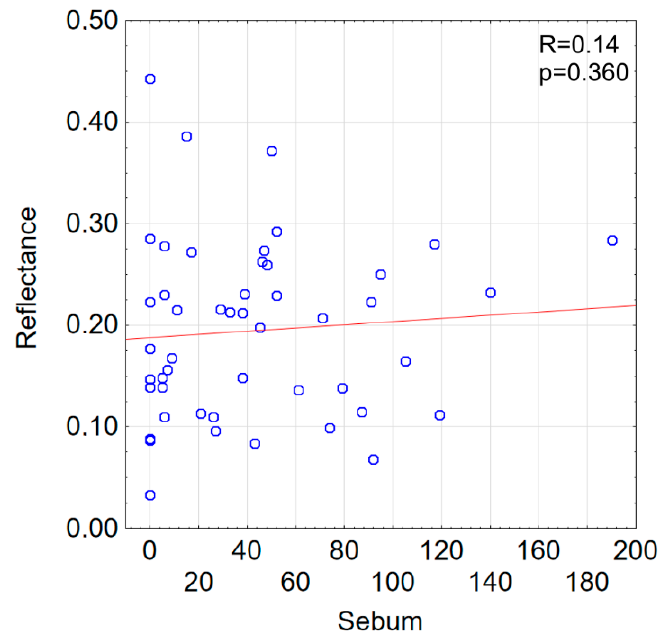
Figure 3. Correlation of sebum and skin reflectance at the wavelength 335–380 nm. Red line— trend line. Negative correlations were found between the amount of sebum and the directional reflectance of the skin at the wavelengths 400–540 nm (R = − 0.32; p = 0.026) (Figure 4) and 480–600 nm (R = − 0.35 p = 0.014) (Figure 5).